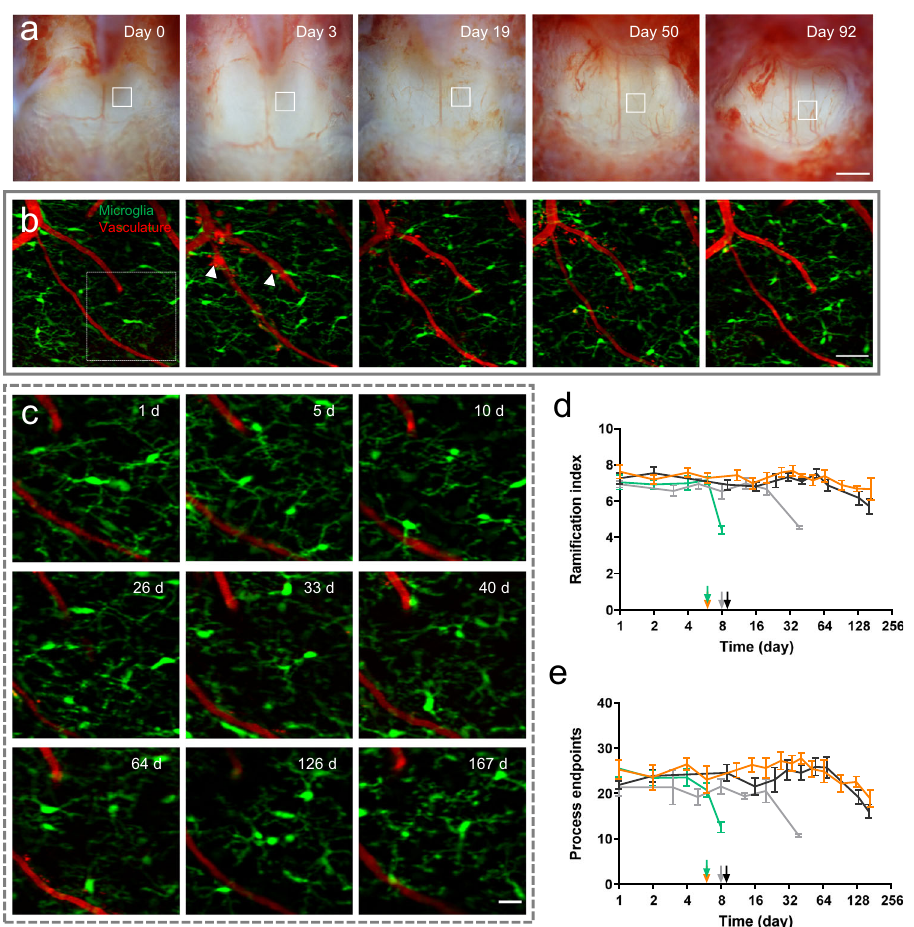
Fig. 3 Long-term spinal cord imaging through optically cleared LF windows. a Bright- fi eld images of an LF window over three months. Scale bar, 500 μ m. b Maximal projections of microglia (green) and vasculature (red) image stacks at the same site in the box region of ( a ). Vasculature labeled by Texas Red dextran was used to navigate to the same region of interest in different imaging sessions. The arrowheads indicate Texas Red dextran labeled perivascular cells and immune cells above the spinal cord. Scale bar, 50 μ m. ( c ) Magni fi cation of the box region in ( b ) shows the detailed structures of microglia and vasculature at indicated times. Scale bar, 50 μ m. ( d , e ) Rami fi cation index ( d ) and number of process endpoints ( e ) as functions of time during longitudinal two-photon fl uorescence imaging. Each curve represents the statistical data of one mouse. Arrows indicate timing of the fi rst surgical clearing of the overgrowing tissue for each mouse. Surgical clearing of overgrowing tissue was performed thereafter for every imaging session. For statistics of rami fi cation index and number of process endpoints, 6 – 10 microglial cells were analyzed for each mouse at each time point. The longitudinal study was terminated when microglial activation was observed, or the imaging region of interest was lost because of the shrunken fi eld of view. Error bars, s.e.m. Source data are provided as a Source Data fi